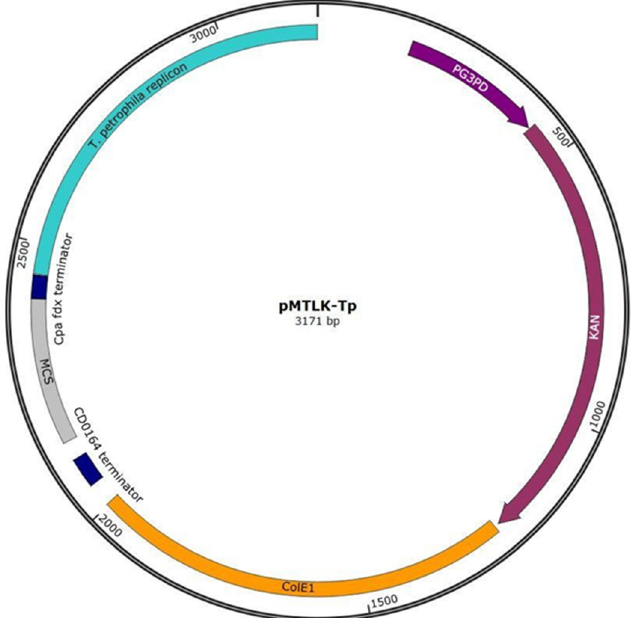
Figure 2. The designed plasmid shuttle vector pMTLK-Tp contains T. petrophila pRKU1 replicon and the thermostable kanR gene, expressed with the P G3PD promoter for plasmid maintenance and selection, respectively, in M. thermoacetica . It also harbours the ColE1 Gram-negative replicon and a multiple cloning site (MCS) for easy downstream cloning.